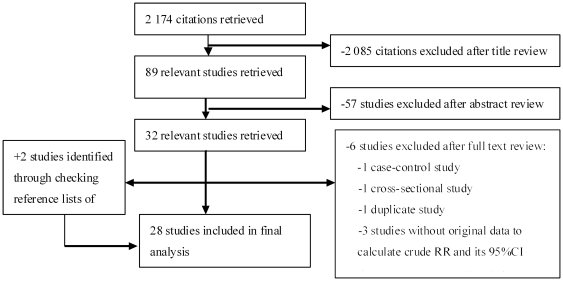
Selection of studies in the Meta-analysis.